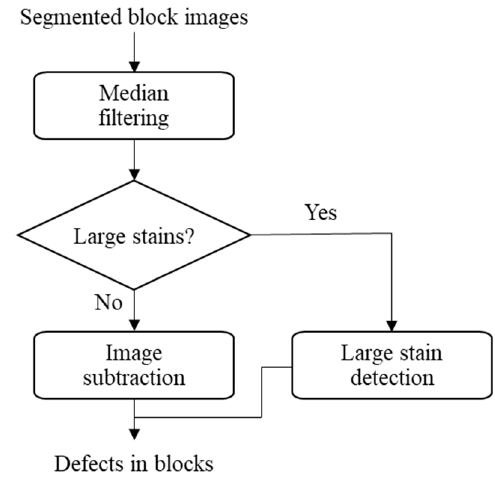
Figure 10. Flow of defect detection in blocks.